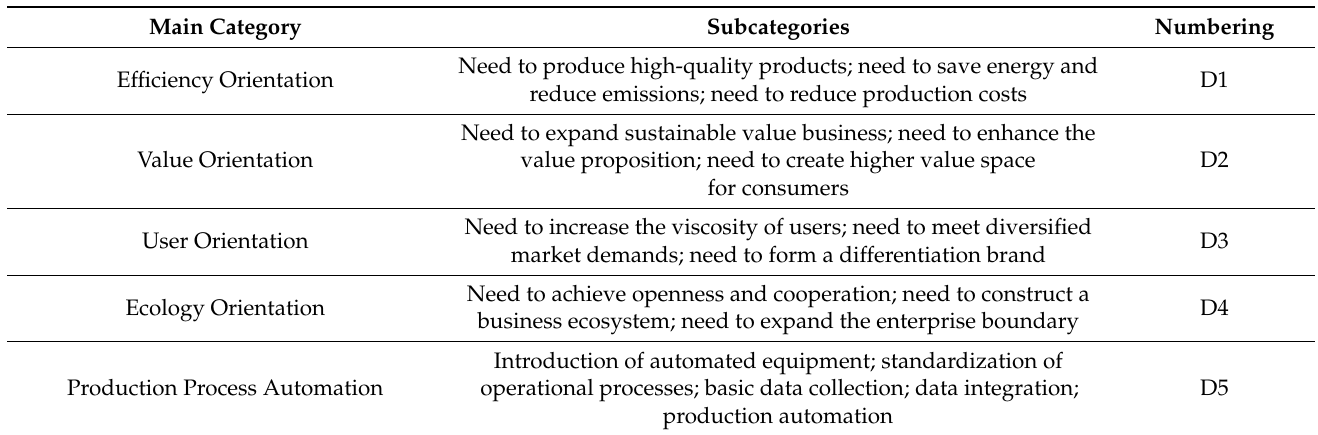
Table 4. Axial coding